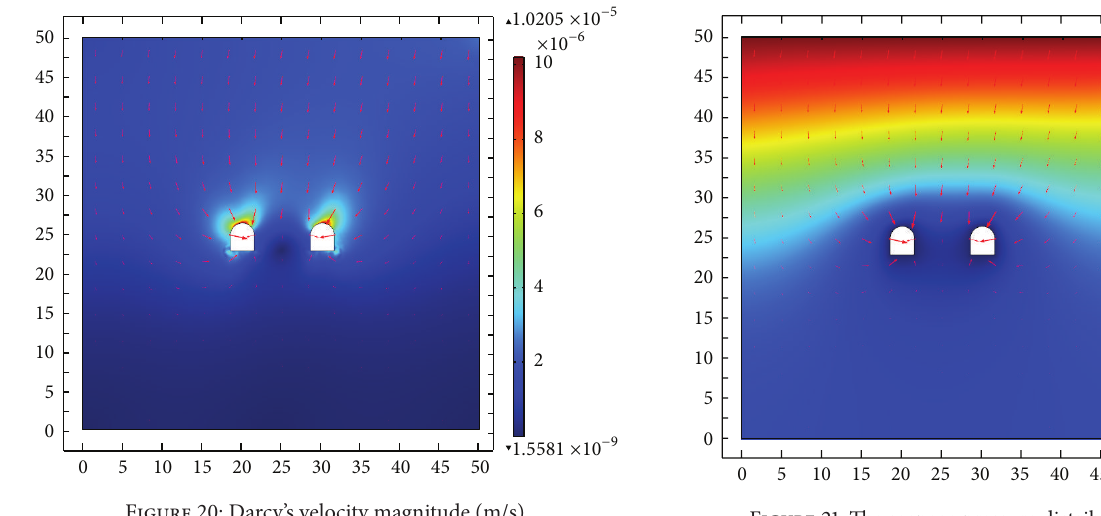
Figure 20: Darcy’s velocity magnitude (m/s). Figure 21: The seepage pressure distribution (Pa).